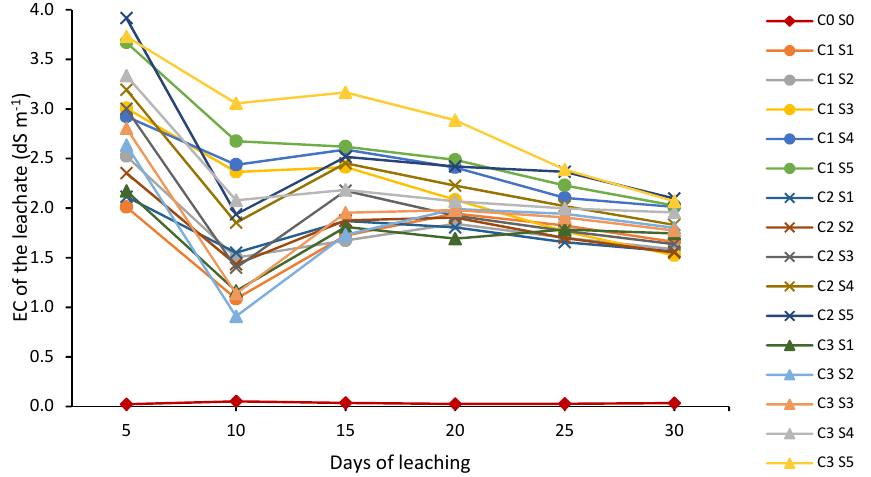
Figure 2. Electrical conductivity of leachates for the different treatments over 30 days of leaching.